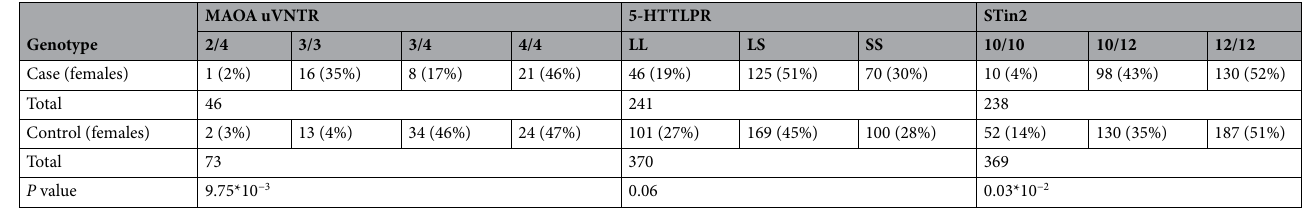
Table 4. Genotypic frequency of MAOA uVNTR, 5-HTTLPR and STin2.